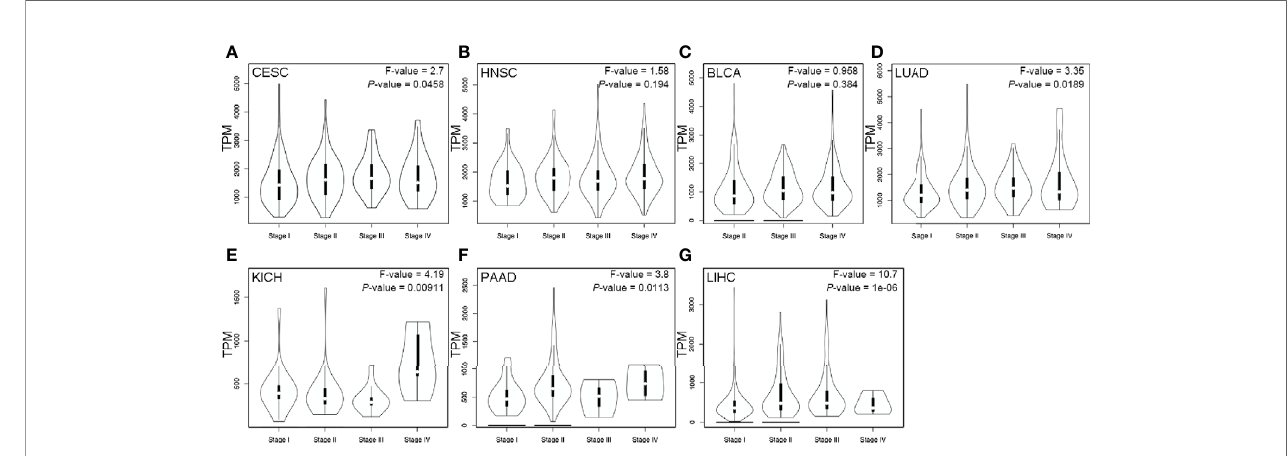
FIGURE 5 | ENO1 expression at different pathological stages of CESC (A) , HNSC (B) , BLCA (C) , LUAD (D) , KICH (E) , PAAD (F) and LIHC (G) . Data were analyzed using one-way ANOVA. The ENO1 expression levels are shown in transcripts per million in Y-axes. CESC, cervical squamous cell carcinoma and endocervical adenocarcinoma; HNSC, head and neck squamous cell carcinoma; BLCA, bladder urothelial carcinoma; LUAD, lung adenocarcinoma; KICH, kidney chromophobe; PAAD, pancreatic adenocarcinoma; LIHC, liver hepatocellular carcinoma.